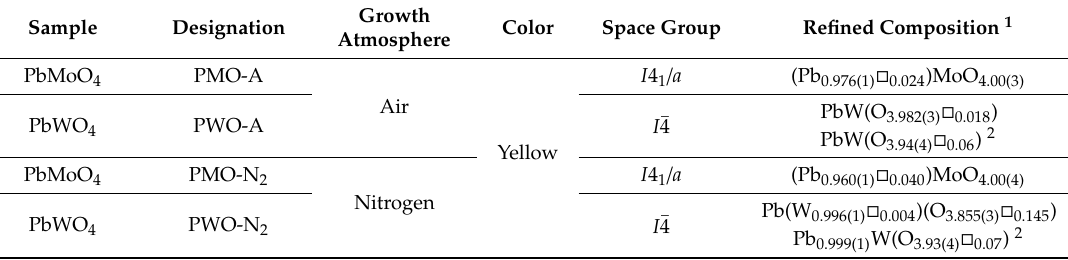
Table 1. Symmetry and refined compositions of PbMoO 4 (PMO) and PbWO 4 (PWO) crystals according to single-crystal X-ray (XRD) and neutron di ff raction (ND)